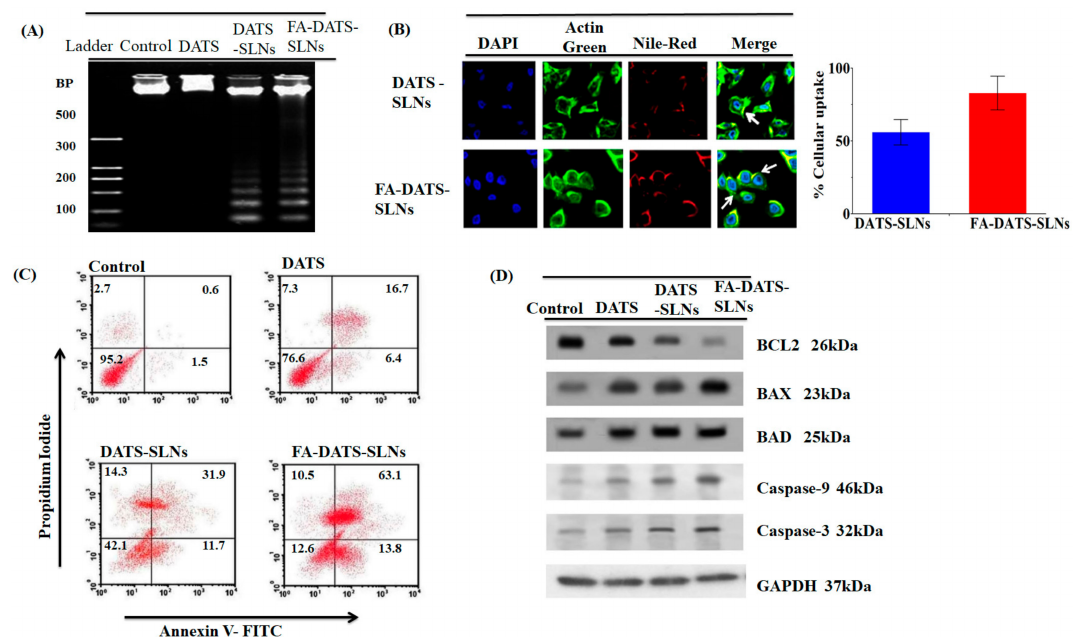
Figure 5. ( A ) DNA fragmentation of the MDA-MB-231 cell line using DATS, DATS-SLNs, and FA-DATS- SLNs. ( B ) Cellular internalization of DATS-SLNs and FA-DATS-SLNs in the MDA-MB-231 cancer cell line indicates that the functionalization of the SLNs surfaces enhances the cellular internalization in TNBC cells. ( C ) Quantitative measurement of apoptosis by AnnexinV-FITC versus PI in MDA-MB-231 cells treated with DATS, DATS-SLNs, and FA-DATS-SLNs. The data clearly indicate high late-phase apoptosis for the FA-DATS-SLNs compared with DATS-SLNs and DATS alone. ( D ) Bcl2-mediated apoptosis induced by FA-DATS-SLNs compared with DATS-SLNs and